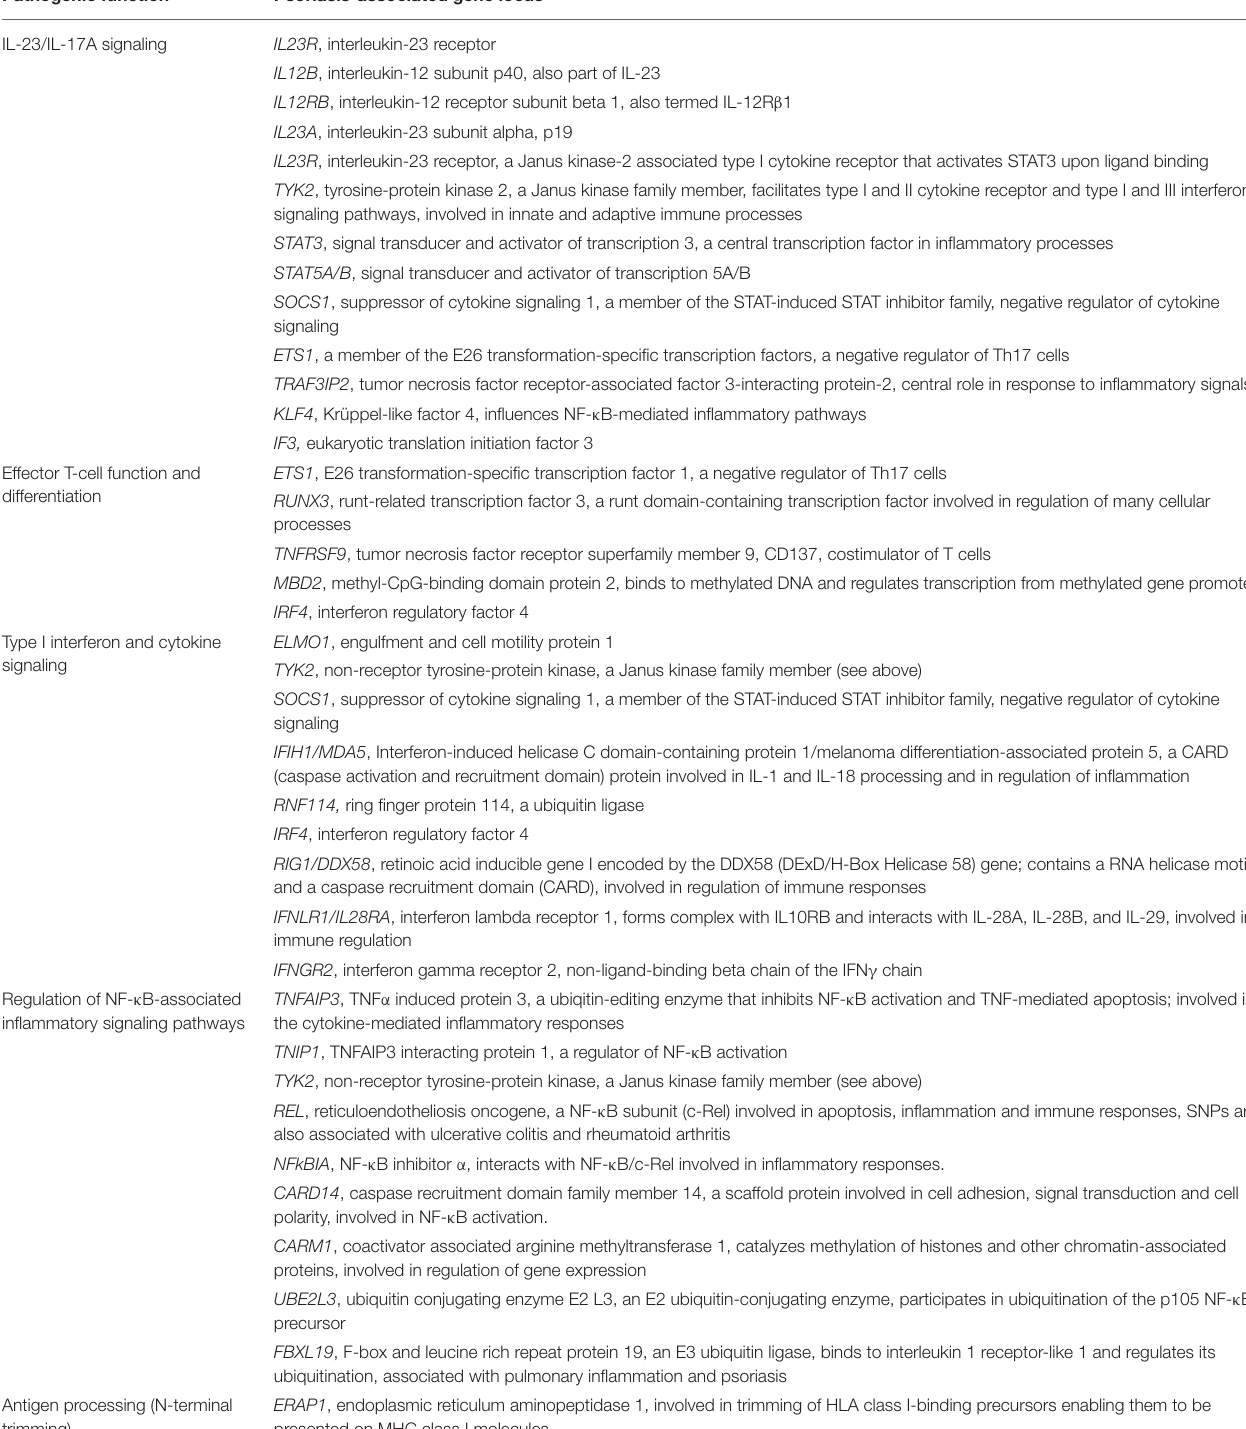
TABLE 1 | Genetic factors implicated in